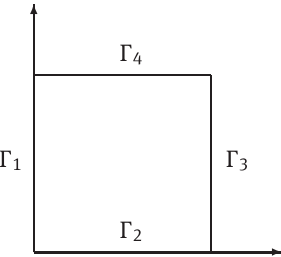
Figure 1: Computational domain: Ω = ( 0, 1 ) × ( 0, 1 )